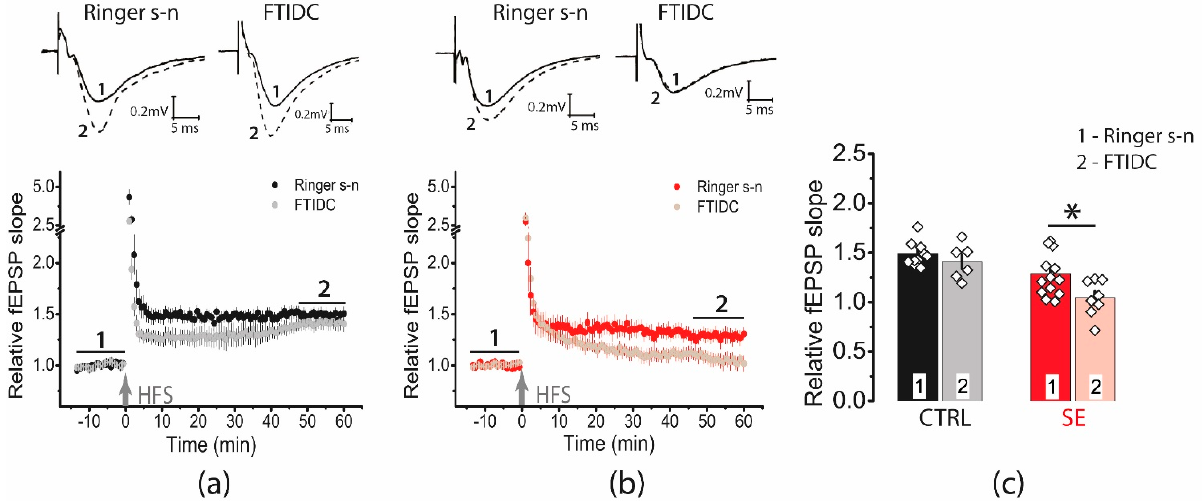
Figure 6. Activation of mGluR1 is necessary for the induction of LTP in the post-SE group. Diagram showing the effect of FTIDS (5 μ M) on the normalized slope of fPSP in control ( a ) and post-SE ( b ) groups. ( c ) Bar graphs (means ± SEM) showing the effect of mGluR1 inhibition by FTIDC on LTP magnitude in different groups. Each rhombus represents a value obtained in an individual animal. Two-way ANOVA: F(seizure) 1,34 = 17.4, p < 0.001; F(FTIDC) 1,34 = 5.7, p < 0.05; F(seizure × FTIDC) 1,34 = 1.3, p = 0.26; following with Tukey’s post hoc tests: * p <